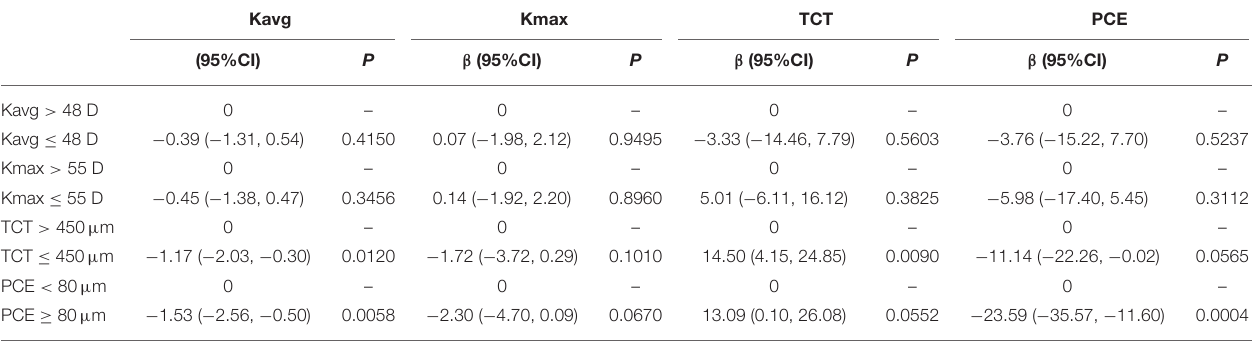
TABLE 4 | Multivariate linear regression analyses for effect of pre-operative data on long-term Kavg, Kmax, TCT, and PCE